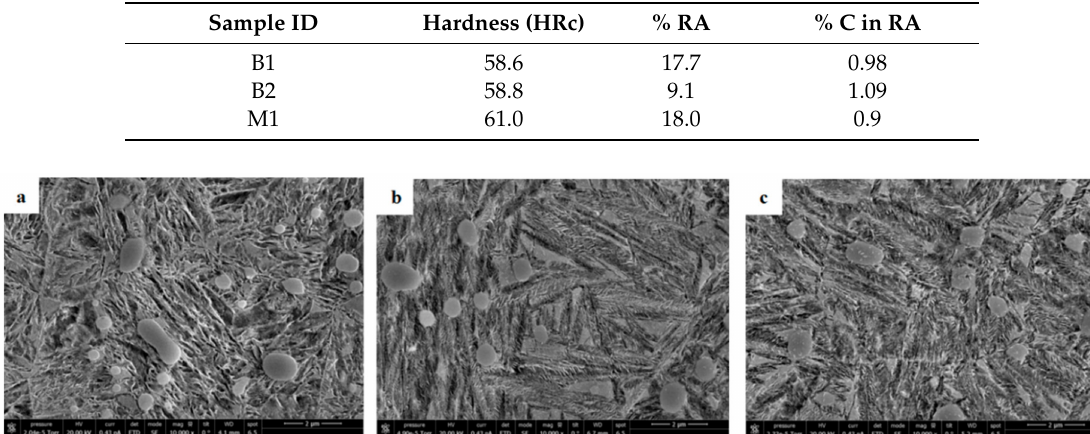
Table 2. Specimen details for martensitic and bainitic samples.